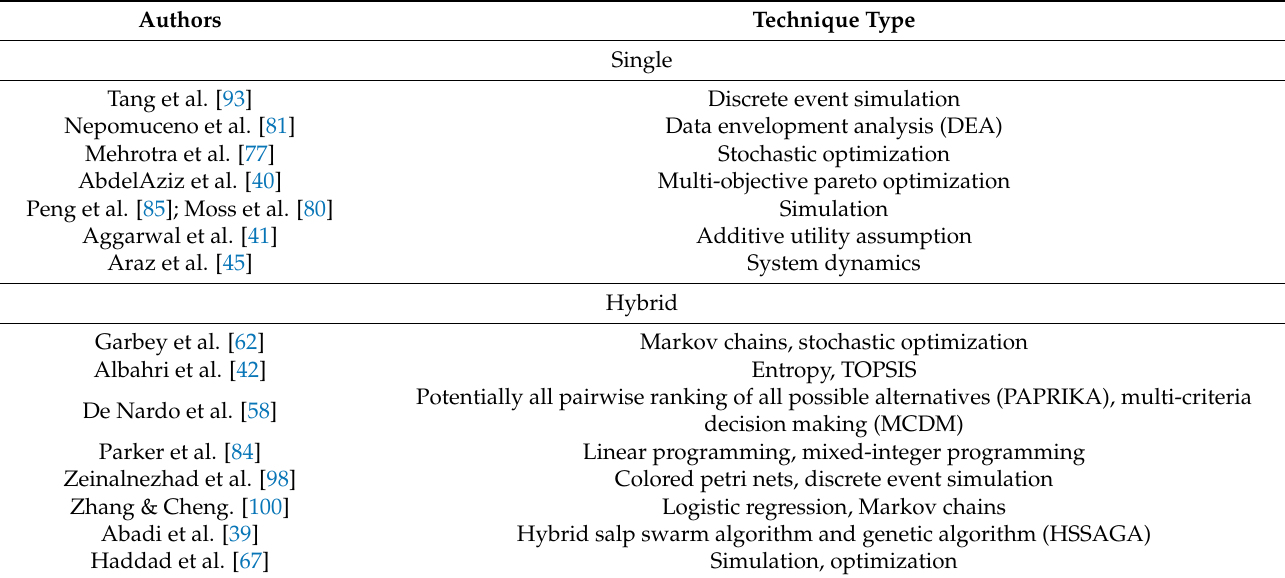
Table 2. Papers demonstrating the use of operational research techniques for augmenting the emergency department response to the COVID-19